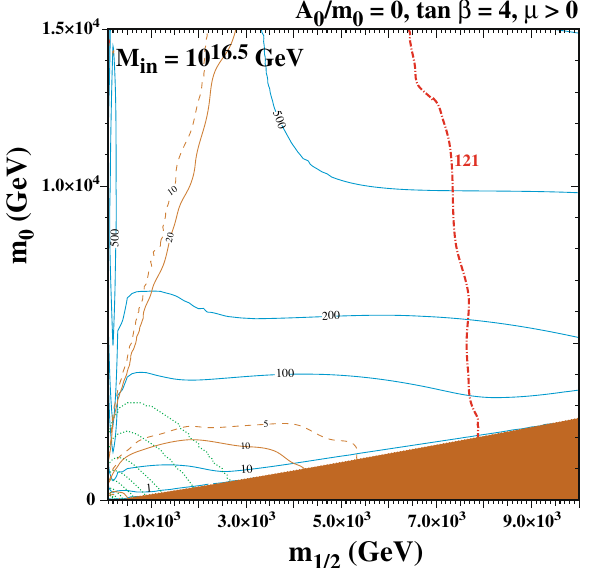
Fig. 3 Representative ( m 1 / 2 , m 0 ) planes in the FSU(5) GUT model. The parameters as the same as in Fig. 1 except that tan β = 4 in the left panel and tan β = 35 in the right panel. Regions with a stau LSP and